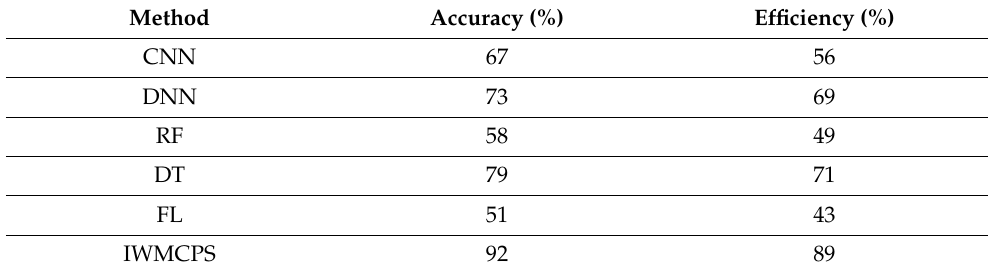
Table 1. Simulation outcome analysis.